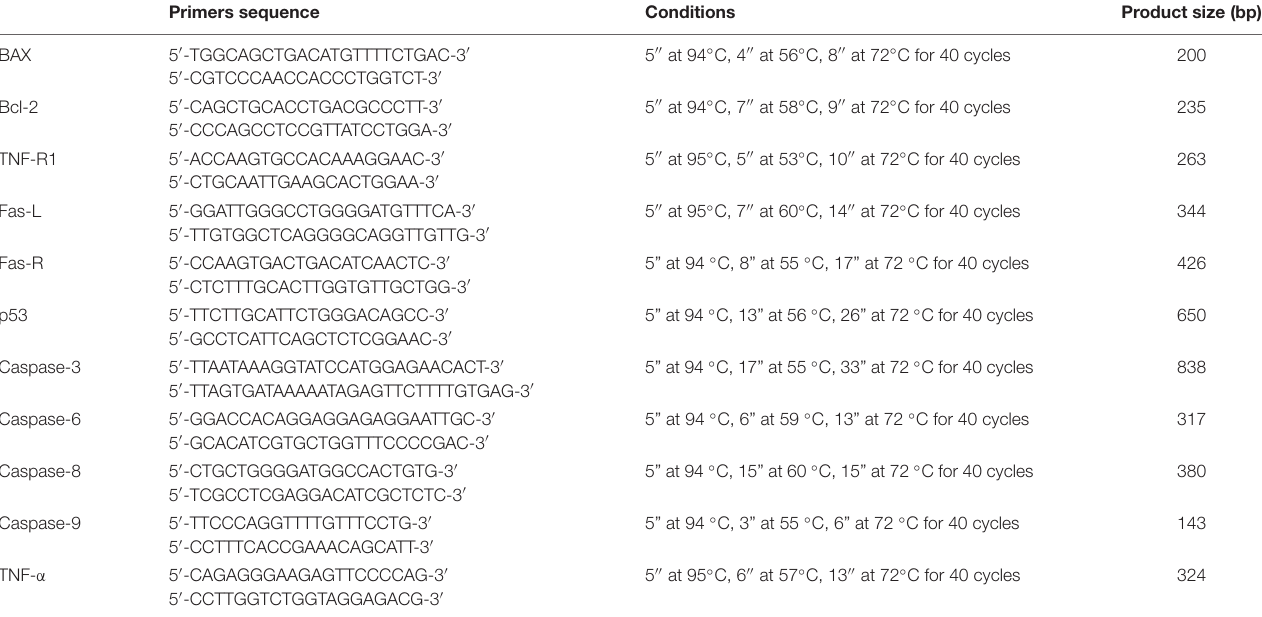
TABLE 2 | Primers sequence for real-time